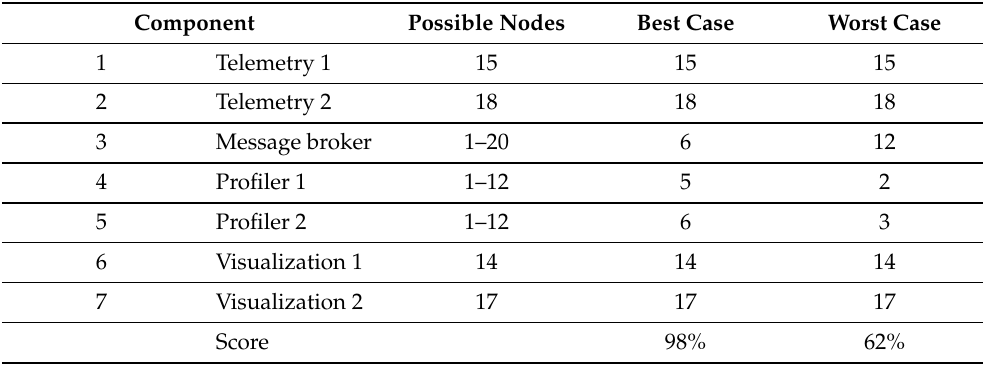
Table 9. Speed profiling deployment nodes